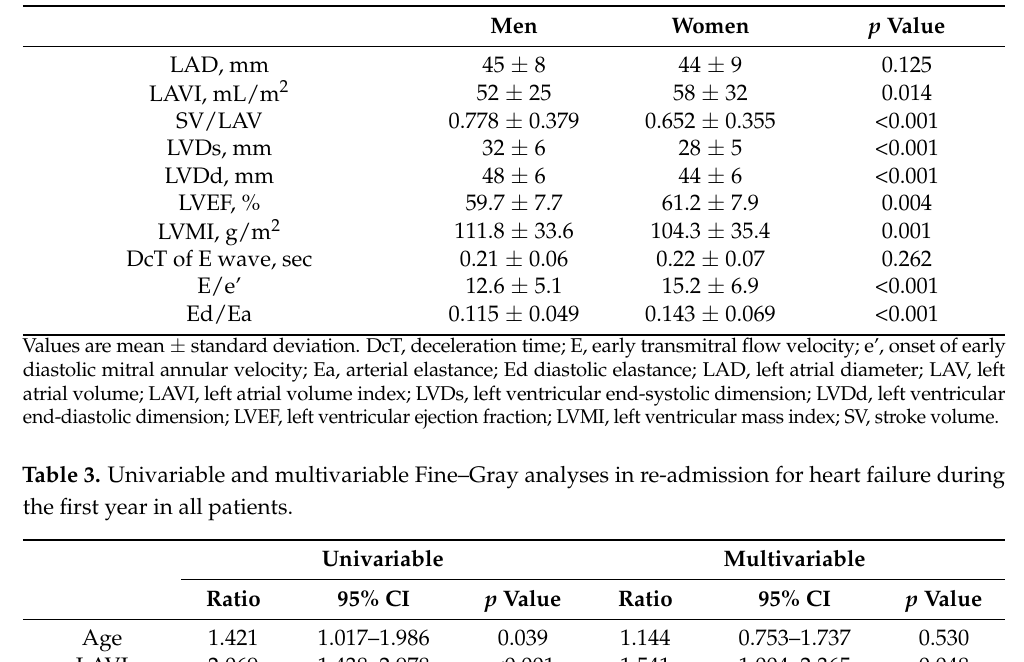
Table 2. Between-sex differences in echocardiographic data before discharge.